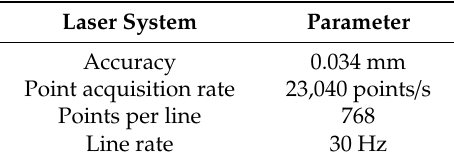
Figure 4. Measurement step of the helmets using a 3D laser scanning machine. Table 5. Laser system.